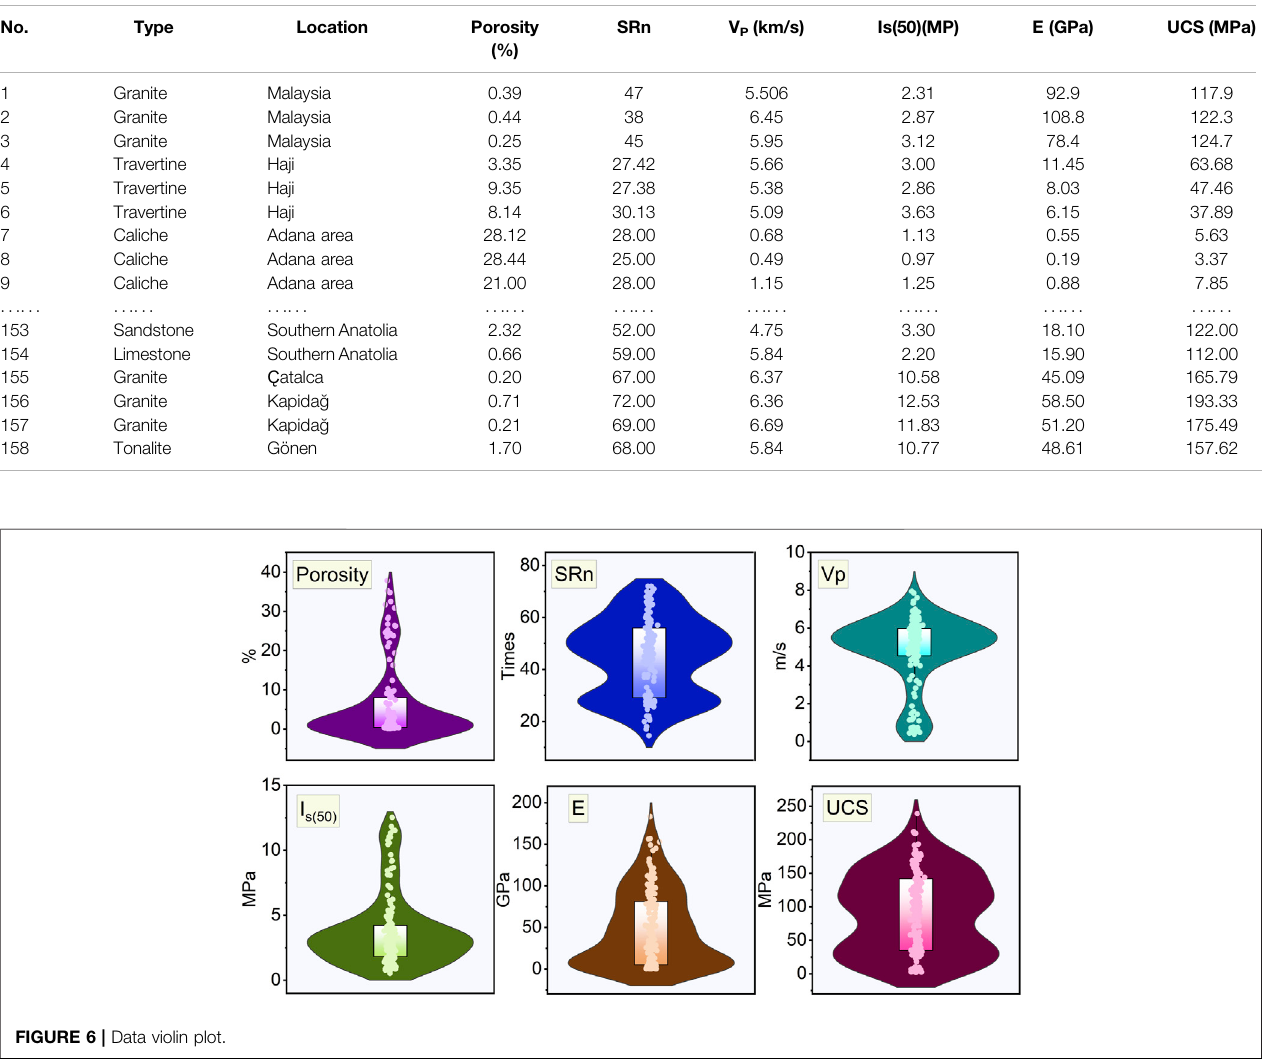
TABLE 1 | Rock sample data.